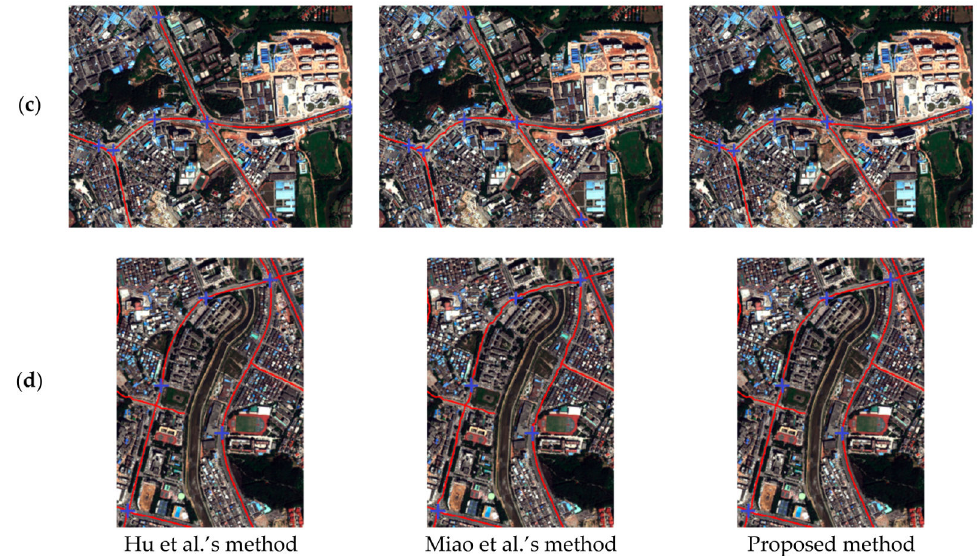
Figure 9. Comparison of the results provided by different road extraction methods for a WorldView-2 image. Road seed points are marked with blue crosses. ( a ) Case 1; ( b ) Case 2; ( c ) Case 3; ( d ) Case 4.